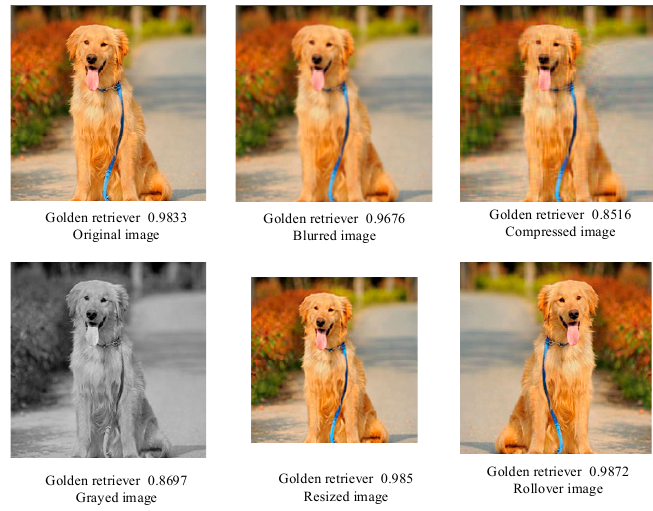
Figure 4. The DNN classifiers has strong robustness to transformed images.